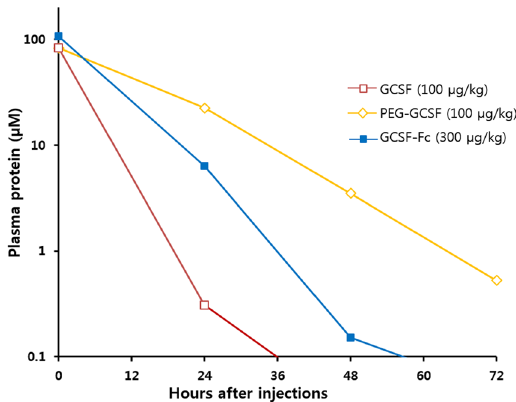
Figure 6. Protein level in plasma after administration of GCSF-Fc, PEG-GCSF and GCSF. The measurements were performed at 24 h, 48 h and 72 h after protein injection. Three groups of rats were utilized for plasma protein measurement, GCSF (100 µ g/kg), PEG-GCSF (100 µ g/kg) and GCSF-Fc (300 µ g/kg). Data are given as means of ± SE of 3 rats/group. The data points at Day 0 were the amount of supplementary proteins, assuming that all proteins were diluted completely in rats’ body